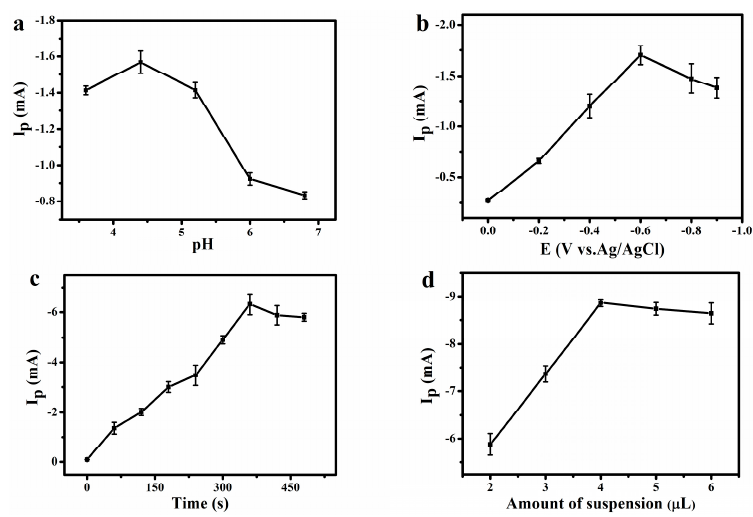
Figure 5. The effect of: ( a ) pH; ( b ) accumulation potential; ( c ) accumulation time; and ( d ) dosage of RGO/CMC/Nafion on the stripping peak current of 1.0 × 10 − 6 mol·L − 1 Cu(II).